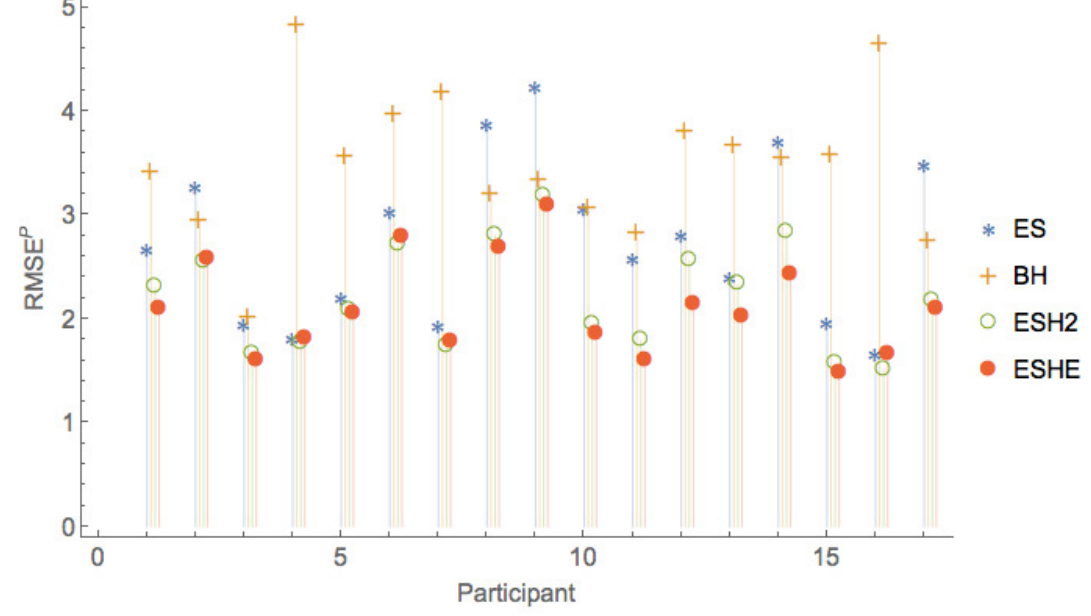
Figure 9. Comparison of leave-one-period-out LOOCV RMSE of selected models for Session